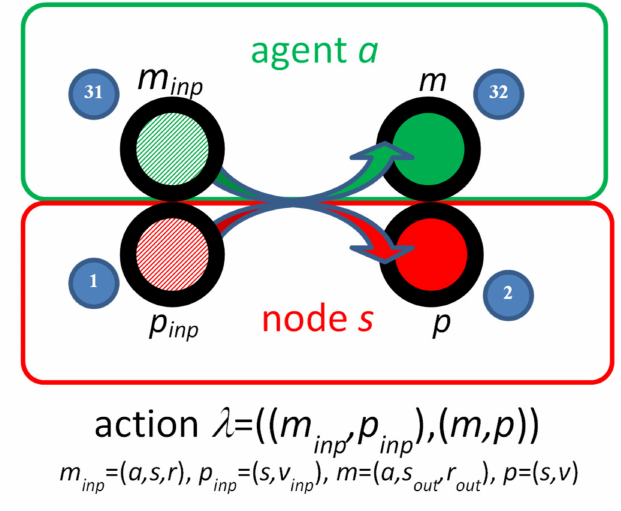
Figure 1. Action in IMDS: relation in ( M × P ) × ( M × P